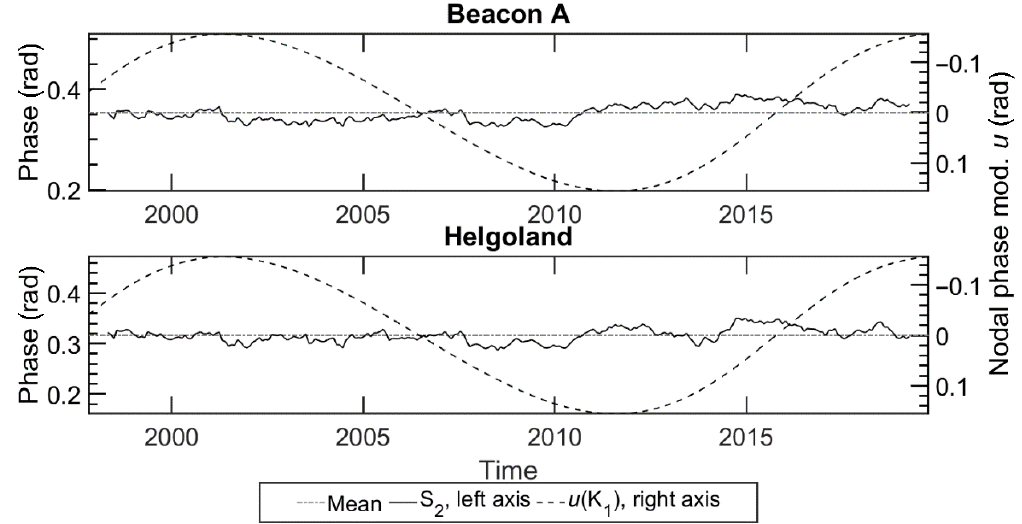
Figure 4. Amplitude on the S 2 frequency, determined for 365.25 d intervals, shifted by 29.5 d shown together with a share of the node factor f of the K 1 ( f (K 1 ) = f (KP 2 )).